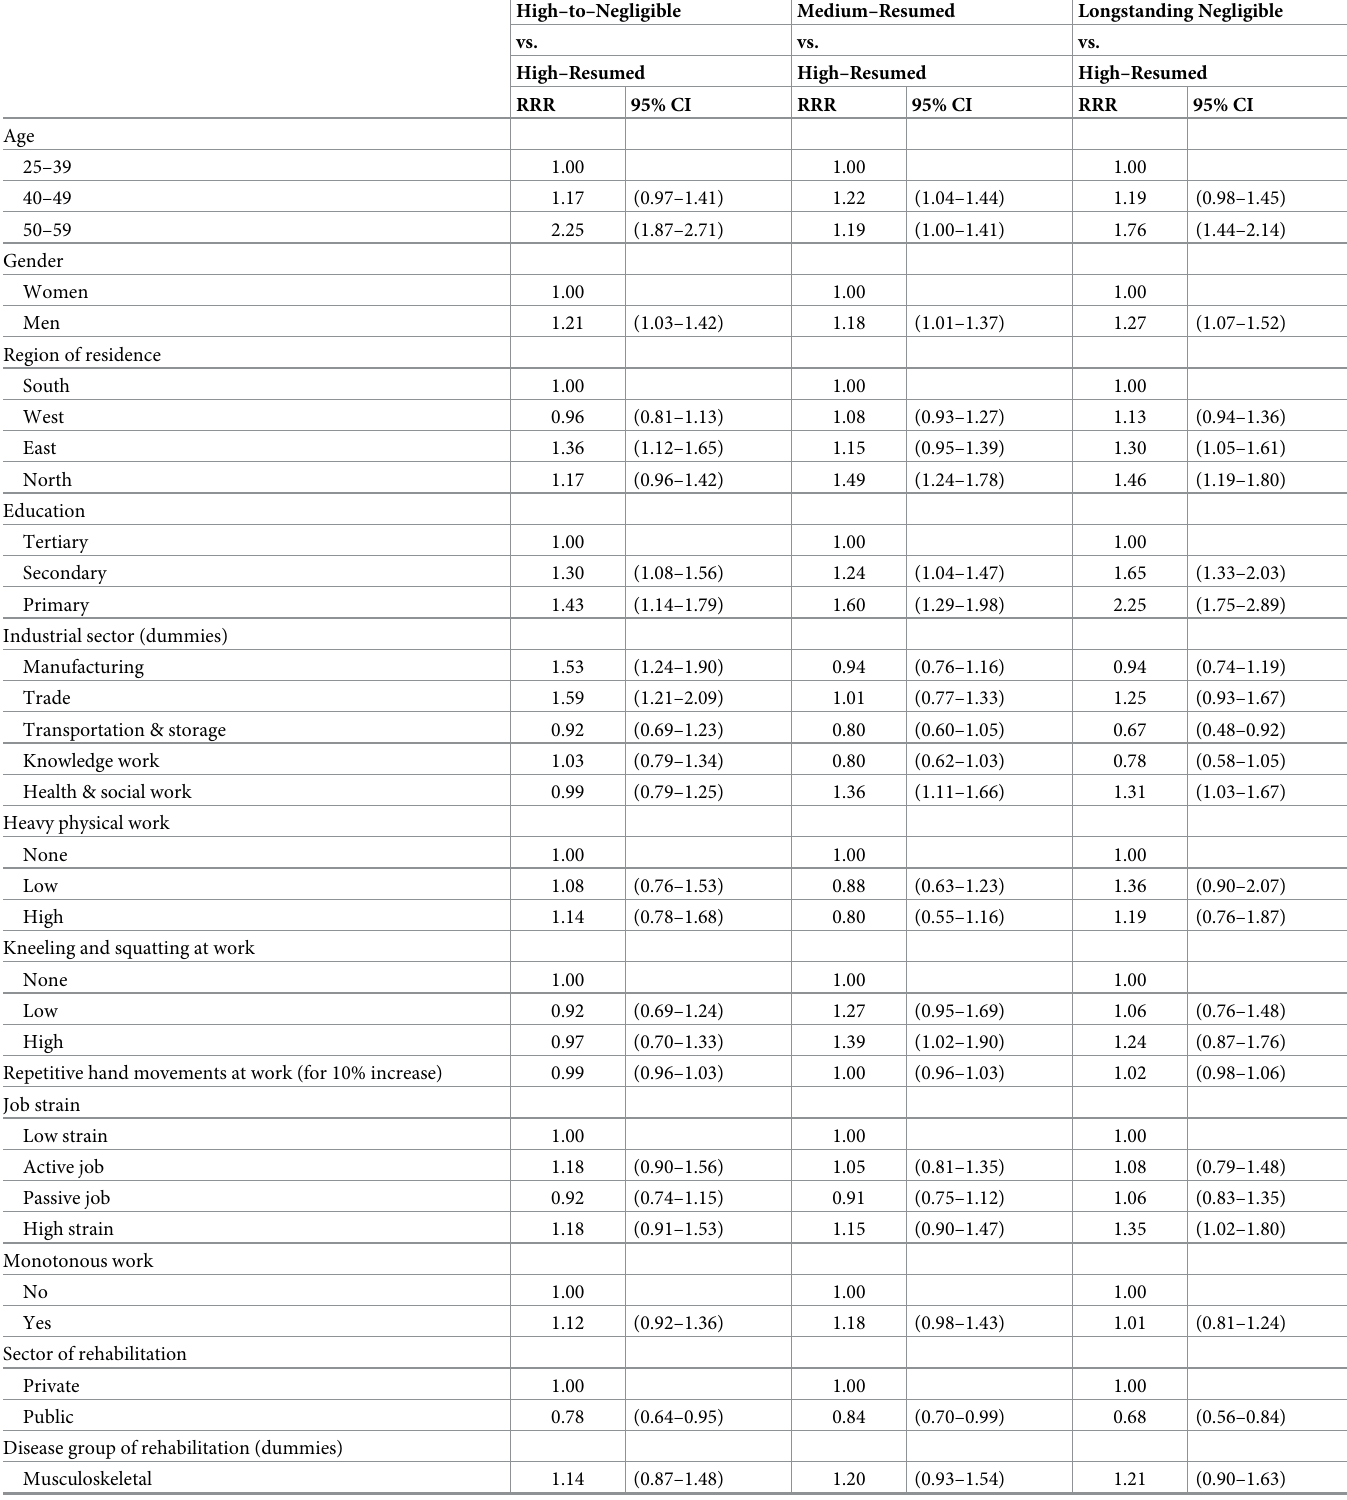
Table 3. Mutually adjusted predictors of being assigned to different trajectory groups of work participation around vocational